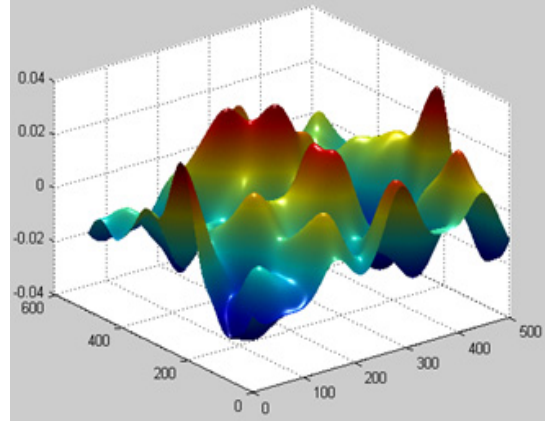
Figure 5. Random Gaussian Surface.